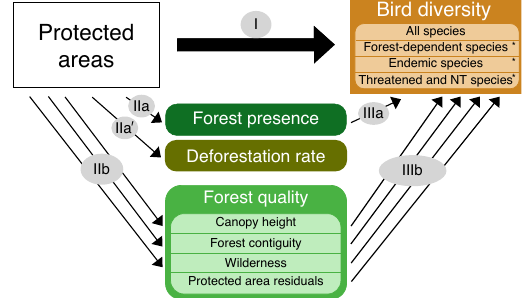
Fig. 2 Framework of the analyses performed to investigate the effectiveness of protected areas at retaining bird diversity. Analysis I: effect of protected areas on bird diversity measured through four indices of bird species richness (all species, forest-dependent species, endemic species, threatened, and near threatened species). The asterisk indicates species of conservation concern. Analysis II: effects of protected areas on forest presence (IIa), local deforestation rates (IIa ′ ), and on three measures of forest quality (canopy height, forest contiguity, and wilderness; IIb). Analysis III: effects of forest presence (IIIa), and of each of the three measures of forest quality and of the residual effect of protected areas (IIIb) on bird